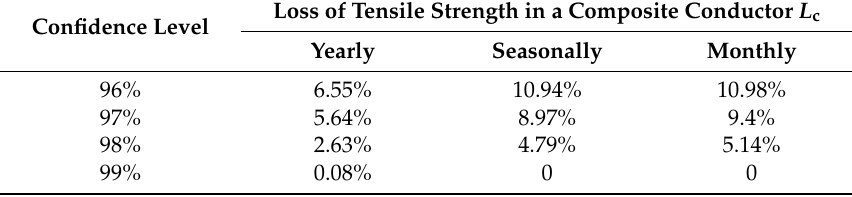
Table 6. Total loss of tensile strength operating at different value with various confidence